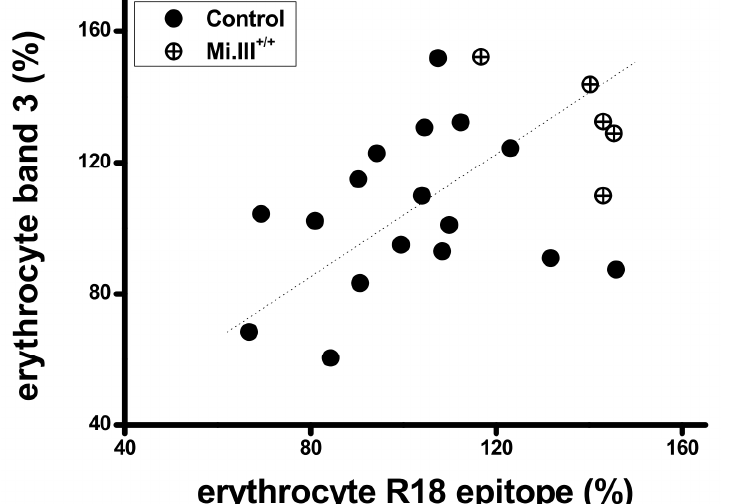
Figure 2. AE1 levels were directly proportional to the GPA-R18 levels on the erythrocyte membrane; GYP.Mur +/+ RBCs generally expressed more AE1 and more R18 epitopes from both GPA and GP.Mur. Fresh RBC samples were immunostained with R18 mAb or with a mix of anti-AE1 mAbs BRIC 6 and BRIC 71 (1:500 dilution each), followed by secondary antibody labeling and flow cytometry. Here, each dot represents the relative levels of AE1 and the R18 epitope of a RBC sample. The geometric means for all non-Miltenberger RBC samples were averaged and set as 100%; all data were expressed in percentage (%). The linearly fitted line showed a rough correlation between the relative levels of AE1 and the R18 epitope on the erythrocyte surface. The data from homologous Mi.III ( GYP.Mur +/+ ) samples were shown in crossed